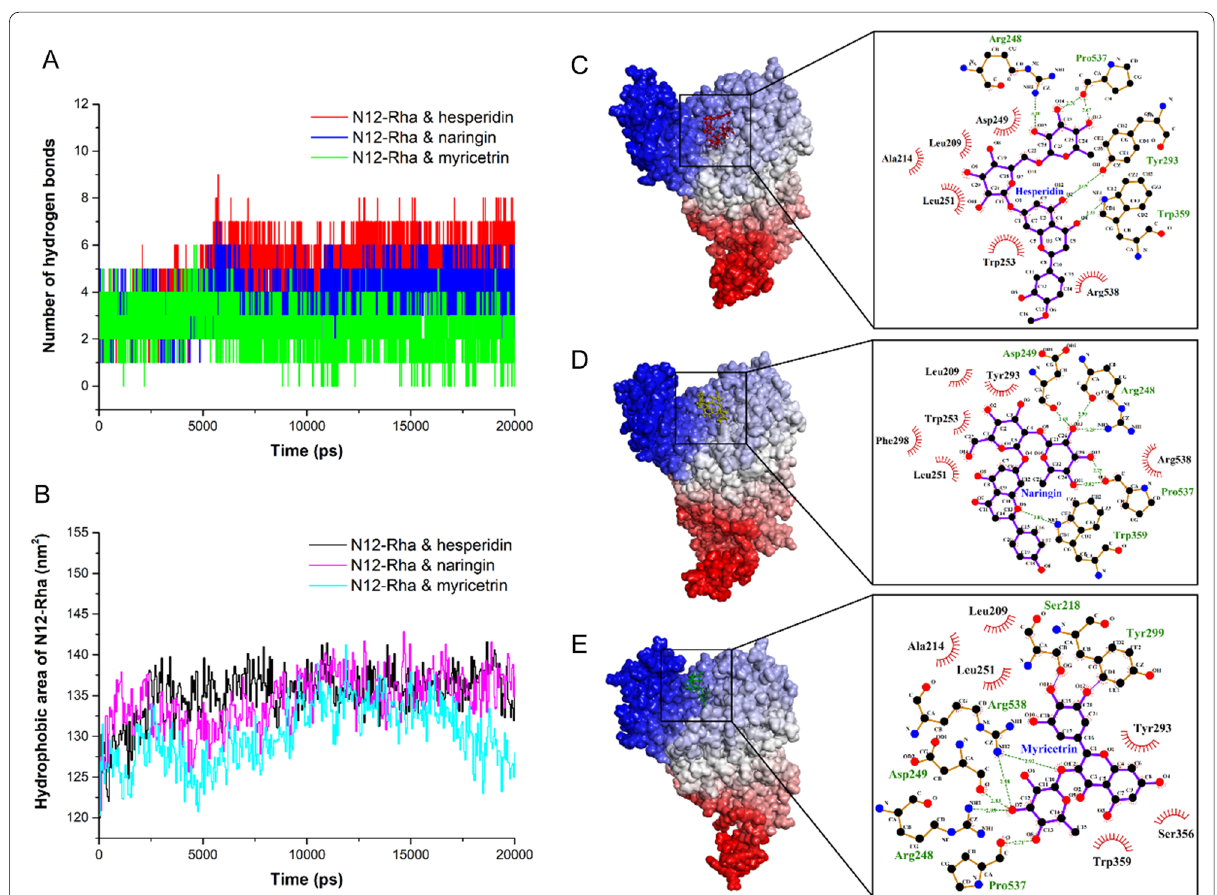
Fig. 6 The hydrogen bond analysis A and hydrophobic area analysis B during 20 ns MD simulation, hydrophobic interaction and hydrogen bonding of hesperidin ( C ), naringin D and myricetrin E binding to N12-Rha during 15–20 ns MD simulation